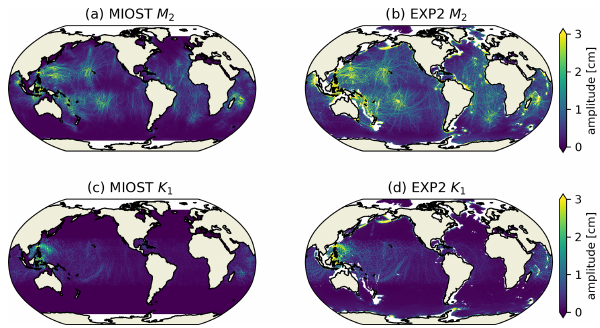
Figure 13. M 2 internal tide amplitude at the surface from MIOST (a) and EXP2 (b) ; (c) and (d) are the same as (a) and (b) but for K 1